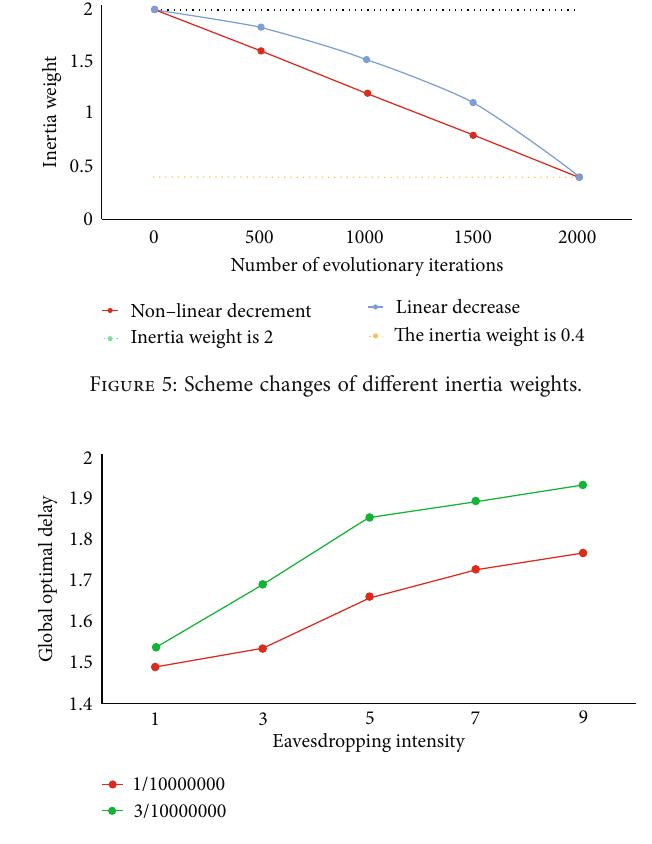
Figure 6: In fl uence of eavesdropping intensity on global optimal transmission